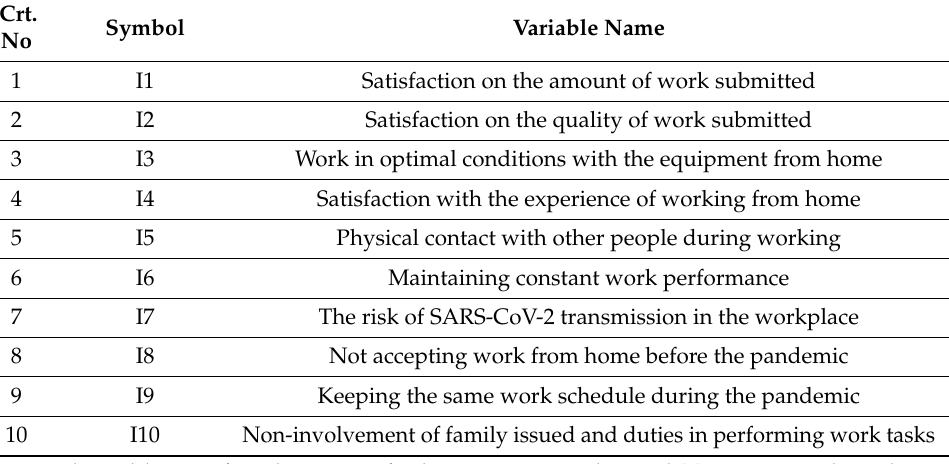
Table 1. Input variables incorporated in the neural network architecture.